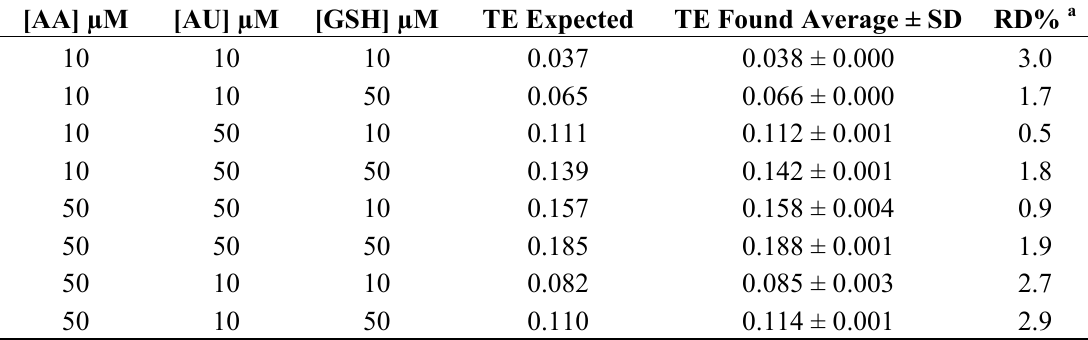
Table 2. Calculated (TE expected) and determined (TE found) values for solutions containing three antioxidant compounds simultaneously using the BCS